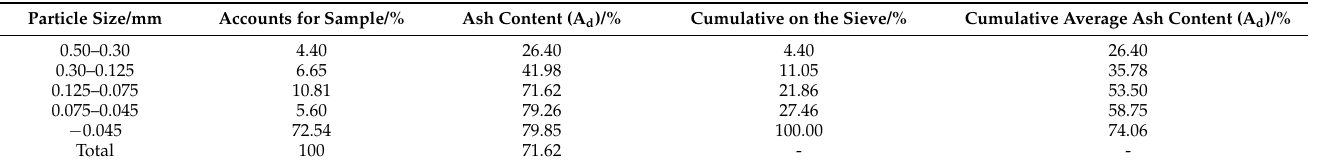
Table 1. Particle size composition of flotation high-ash tailings.